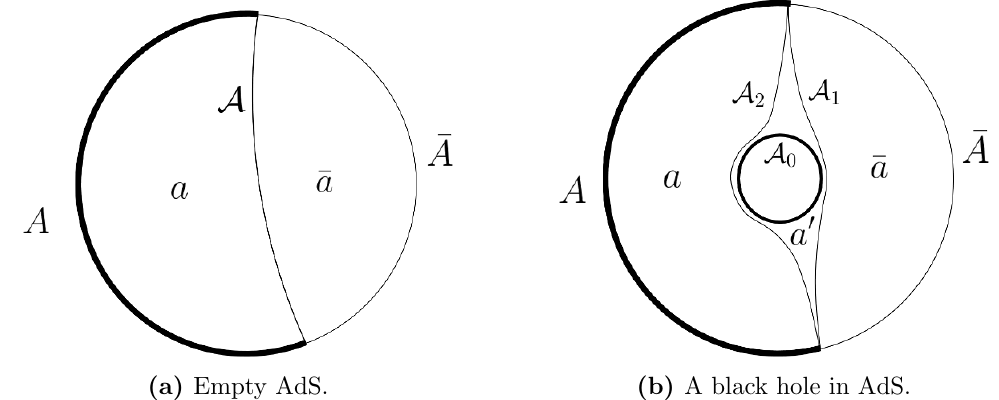
Figure 4 . Ryu-Takayanagi surfaces for empty AdS-space and a black hole in AdS. In each case, the boundary is separated into two regions, A and (cid:22) A . In empty AdS, the boundary between these regions is also the boundary of a single minimal surface through the bulk, with (divergent) area A , which is known as the Ryu-Takayanagi or RT surface. This minimal surface separates the bulk into two regions, a and (cid:22) a , which we refer to as the entanglement wedges of A and (cid:22) A respectively. When a black hole with horizon area A 0 is introduced to the bulk, it creates in(cid:12)nitely many locally minimal surfaces with the same boundary as A and (cid:22) A . In particular we are interested in the minimal surface homologous to (cid:22) A with area A 1 and the minimal surface homologous to A with area A 2 . They divide the bulk into three regions a , (cid:22) a and a 0 , where a 0 lies between the minimal surfaces and contains the black hole. For the thermal or canonical ensemble, regions a and (cid:22) a form the entanglement wedges of A and (cid:22) A